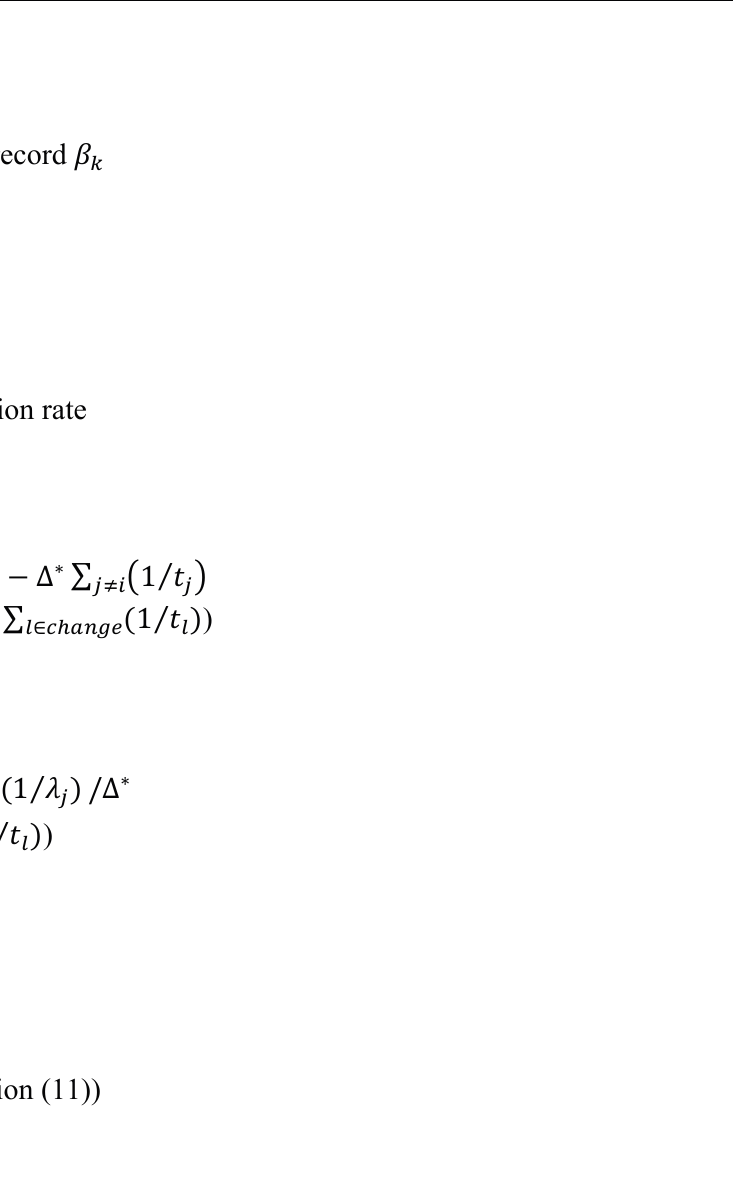
Algorithm 1 Pseudo-code of the proposed